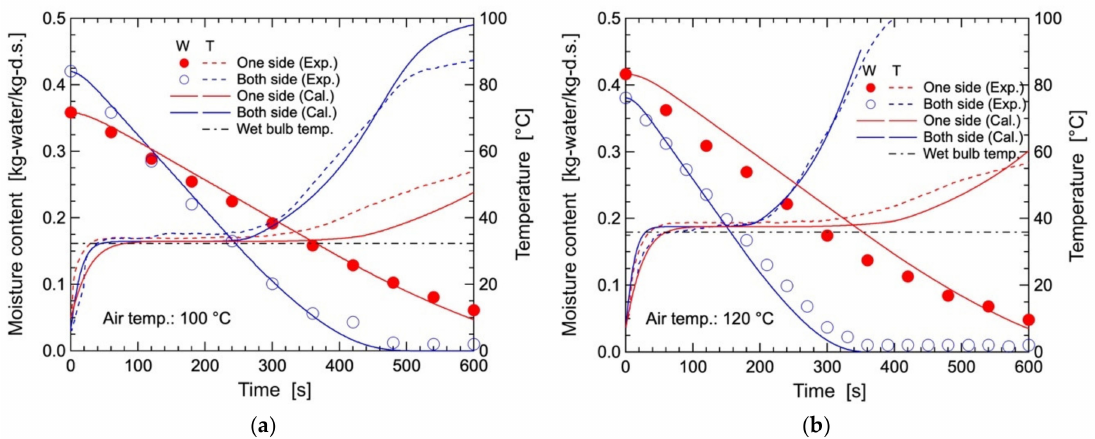
Figure 5. Transient behavior of temperature and moisture content during drying: ( a ) air temperature 100 ◦ C; ( b ) air temperature 120 ◦ C.